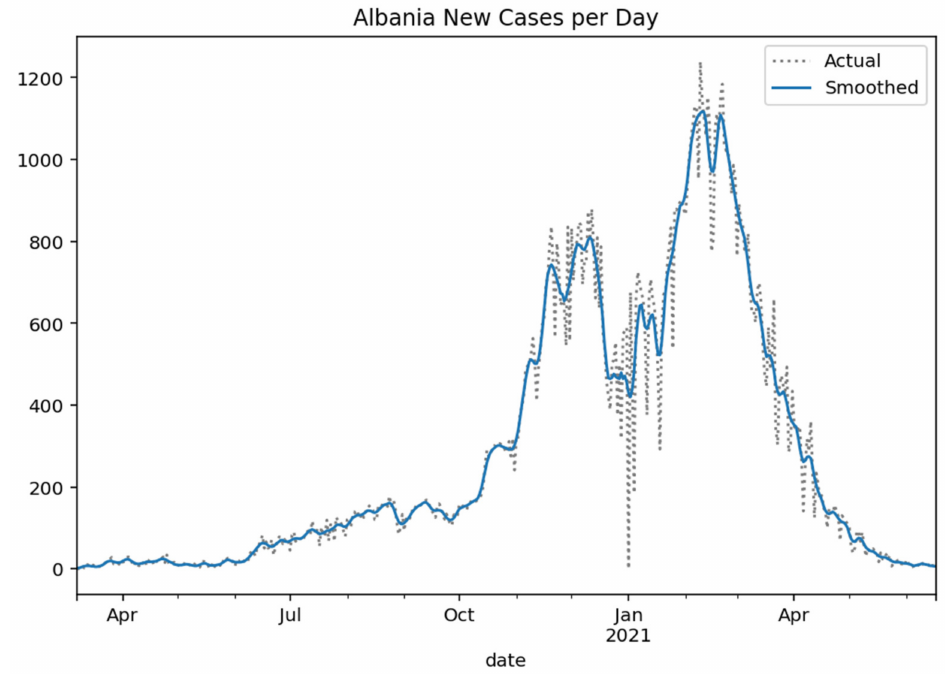
Figure 2. Albania new cases per day (Gaussian smoothed).